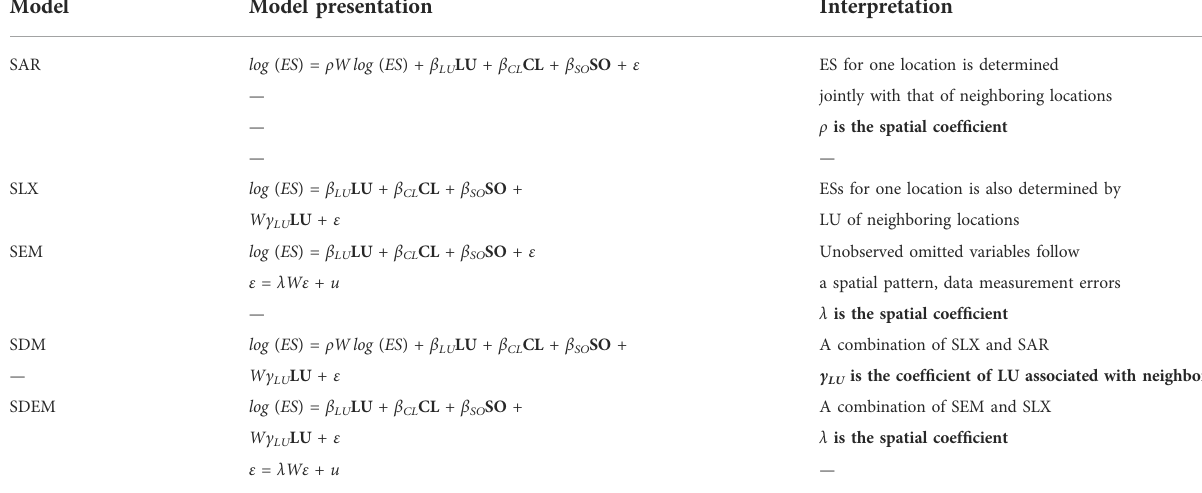
TABLE2Summaryoftheestimatedspatialmodelspeci fi cations. W istheweightmatrix, β aretheestimatedparametervectors, LU aretheproportions of land use area, CL are the weather variables, SO are the proportions of soil texture area, and  are the error terms.